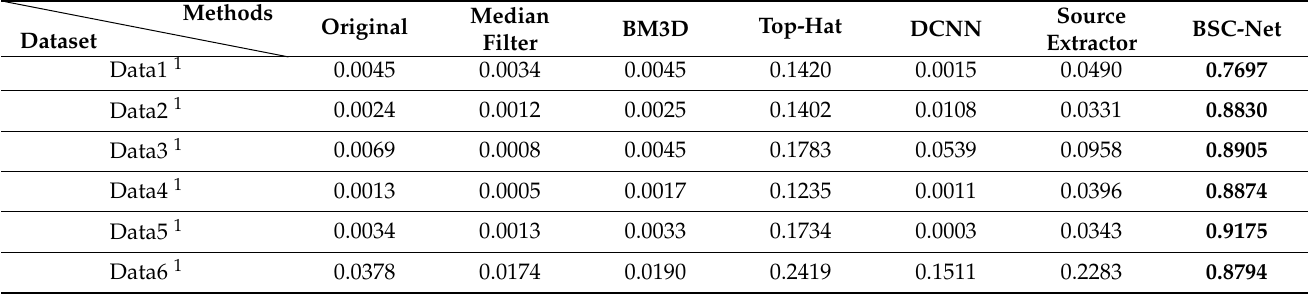
Table 2. The quantitative results on different datasets based on SSIM.